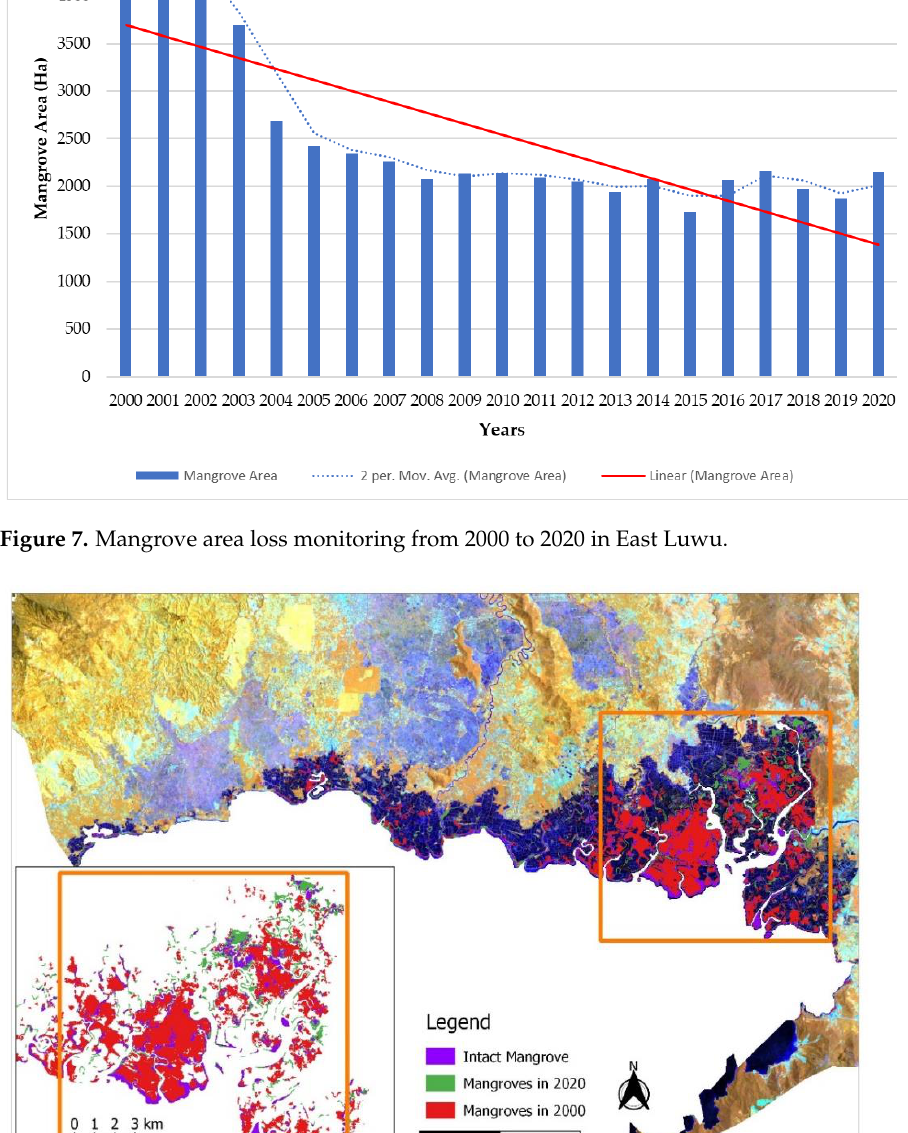
Figure 7. Mangrove area loss monitoring from 2000 to 2020 in East Luwu.